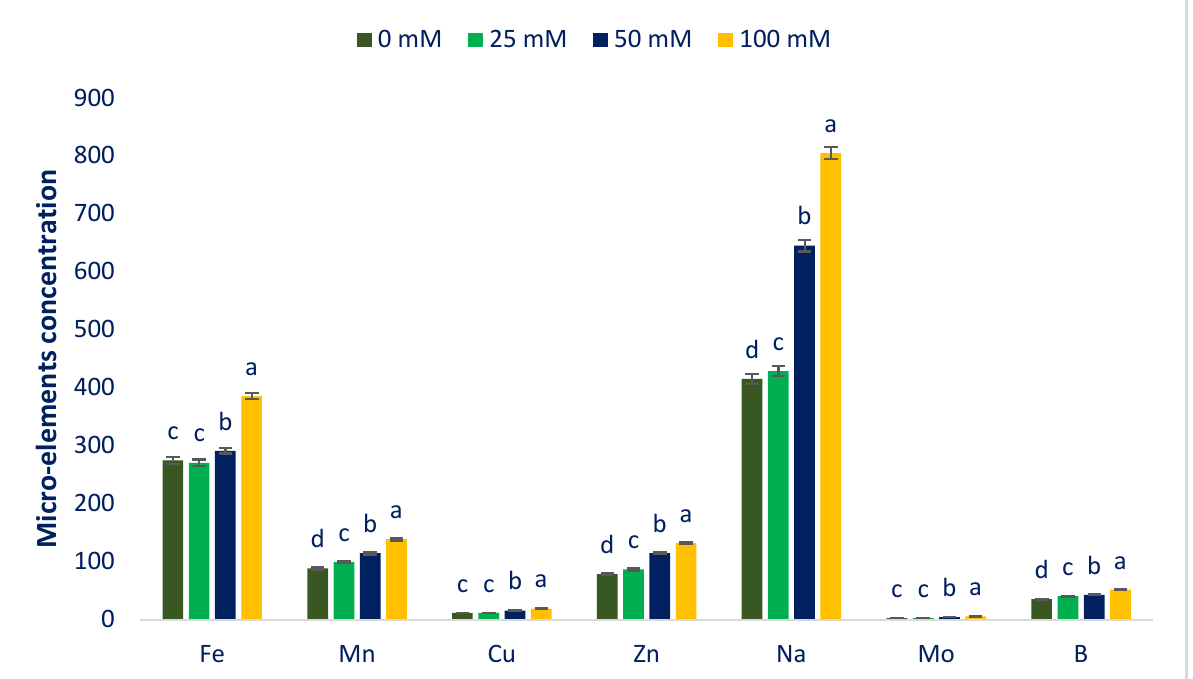
Figure 5. Microelements (µg g − 1 DW) of Lalshak as influenced by salt stress ( n = 6). Dissimilar letters in the bars varied significantly by DMRT ( p < 0.01).